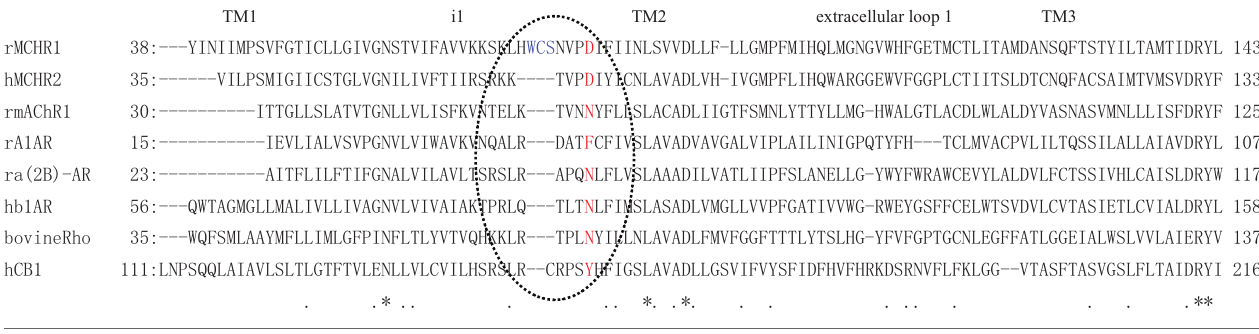
Table 5 | Amino acid sequence alignment from the transmembrane 1 (TM1) to TM3 of rat MCHR1 and other GPCRs. (cid:3) (cid:3) TM1